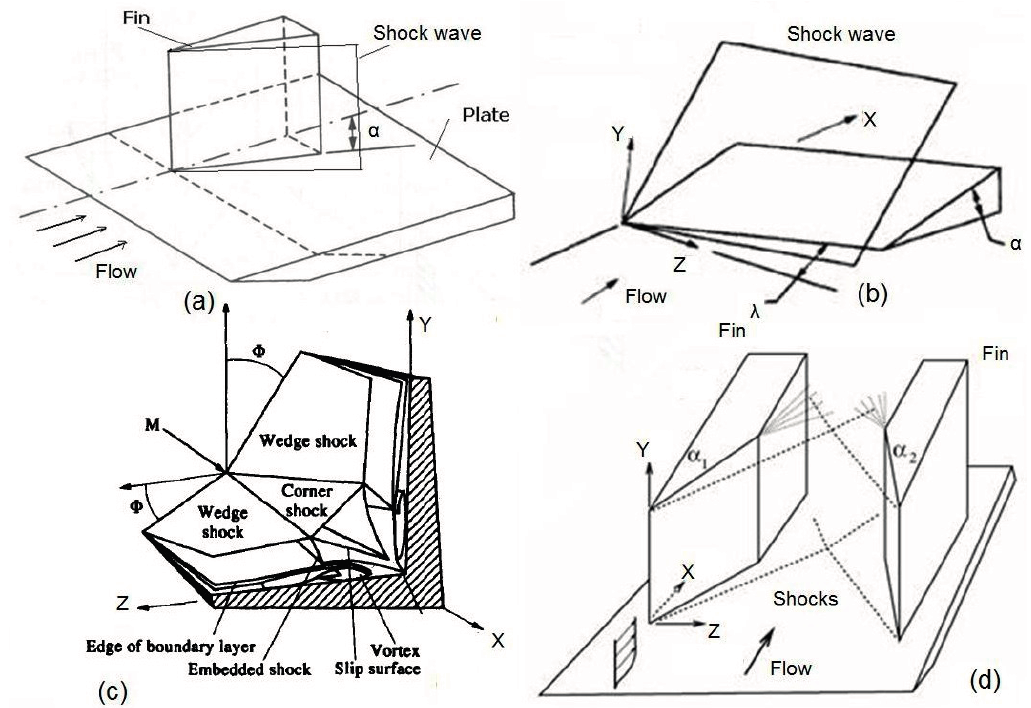
Figure 3. Generic configurations of SBLI used for experimental and computational studies.